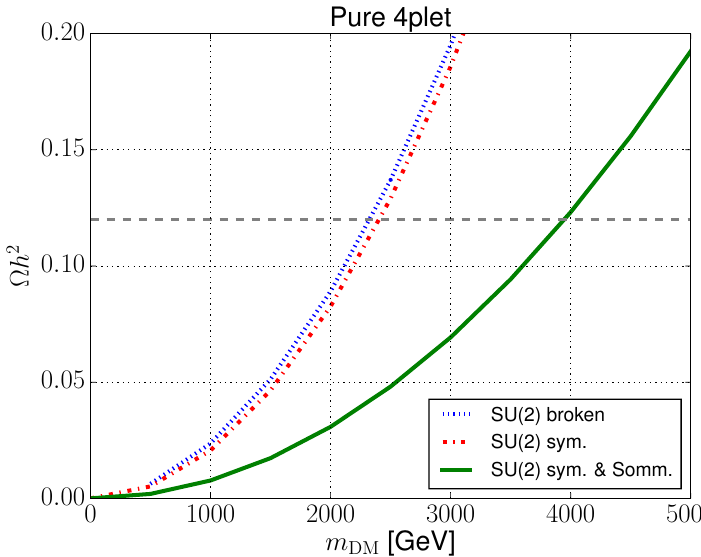
Figure 9. Pure 4-plet relic abundance (cid:10) h 2 including the Sommerfeld corrections (continuous brown) or not (red dotted) in the s-wave SU(2) L symmetric limit for the annihilation of quadru- plet dark matter. With the blue dashed line we also show the results obtained with micrOMEGAs neglecting the Sommerfeld corrections in the SU(2) L broken